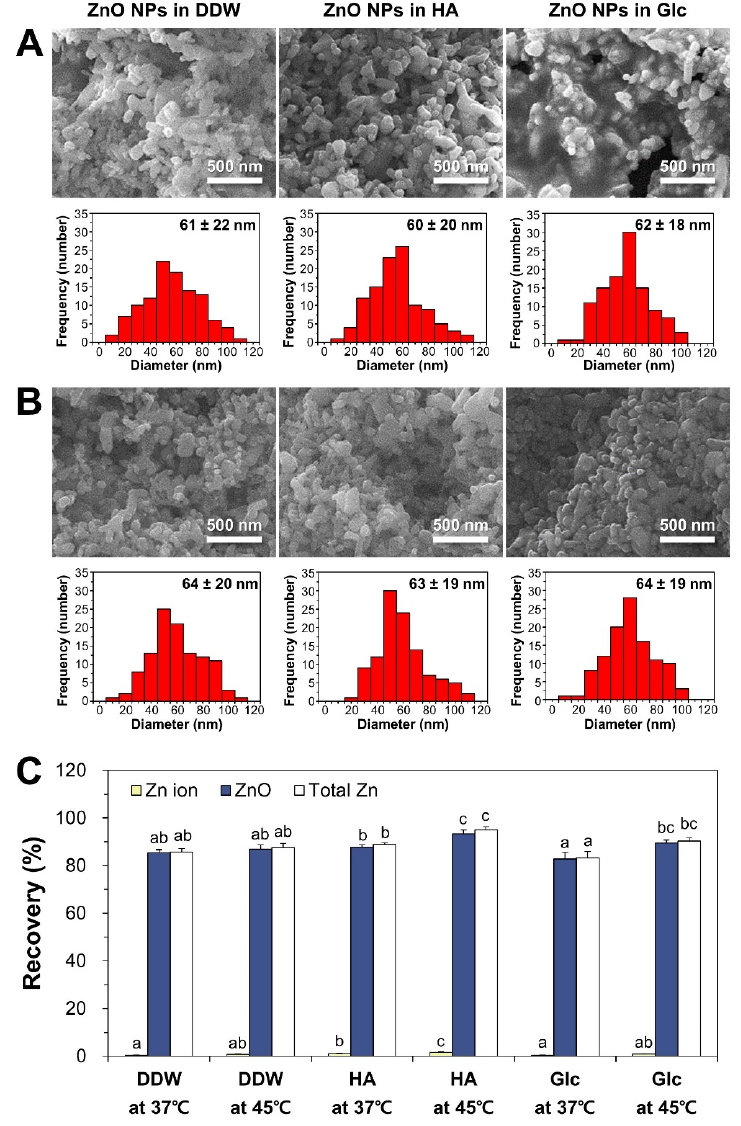
Figure 2. Field emission-scanning electron microscopy (FE-SEM) images and size distribution of pristine ZnO NPs in di ff erent dispersants ( A ) before CPE and ( B ) after CPE. ( C ) Recovery (%) of Zn ions, ZnO particles, and total Zn levels obtained from pristine ZnO NPs by CPE. Size distributions were obtained by randomly selecting 100 particles from FE-SEM images. Di ff erent lower-case letters (a,b,c) indicate significant differences among different CPE conditions ( p < 0.05).